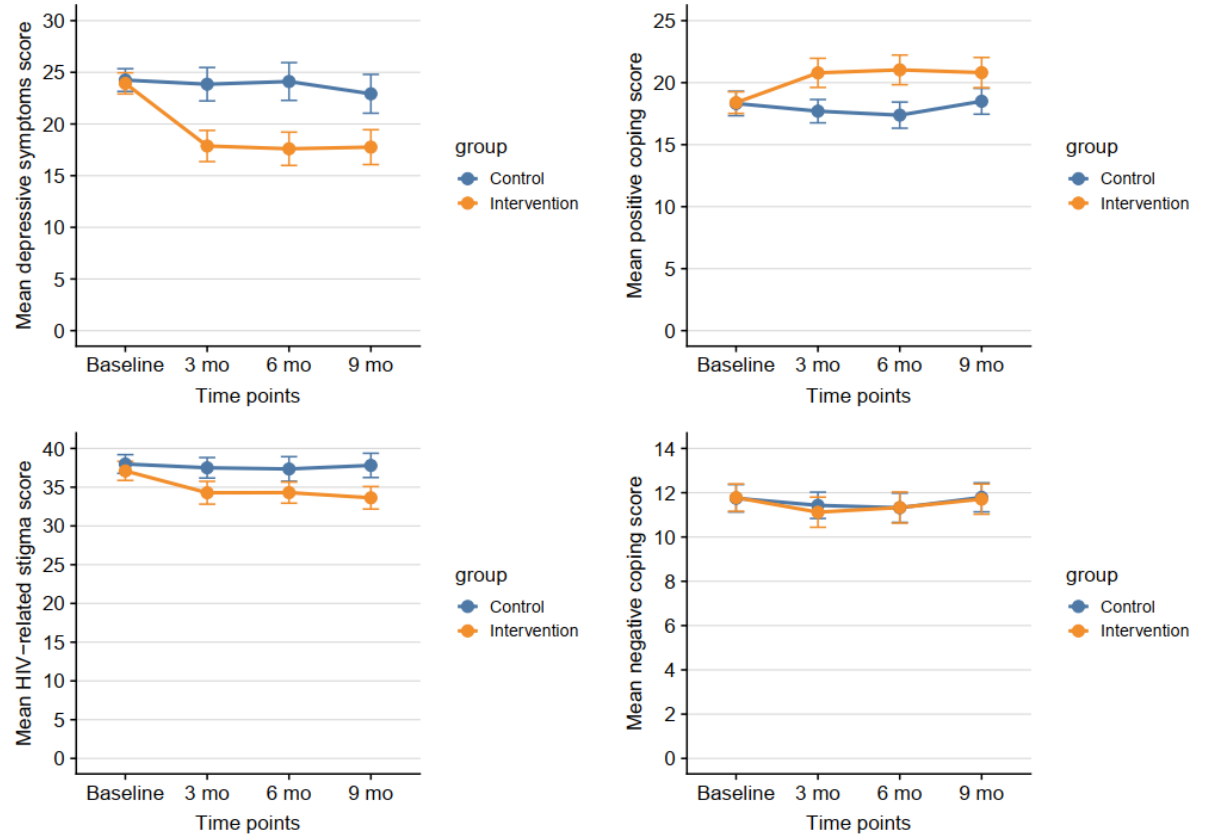
Figure 1. Measurements of depressive symptoms, coping, and HIV-related stigma over time. Error bars indicate 95% confidence